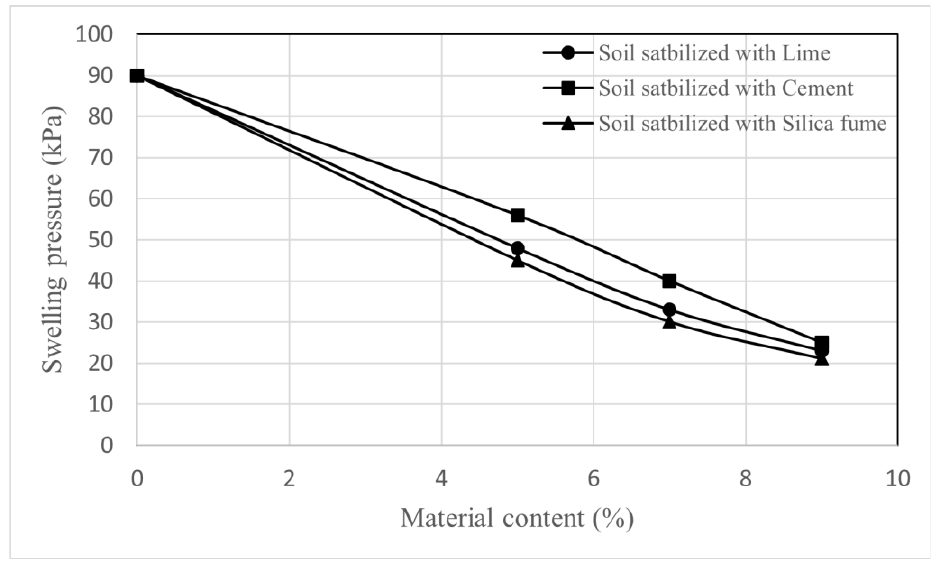
Figure 7. Swelling pressure for different percentages of additives.